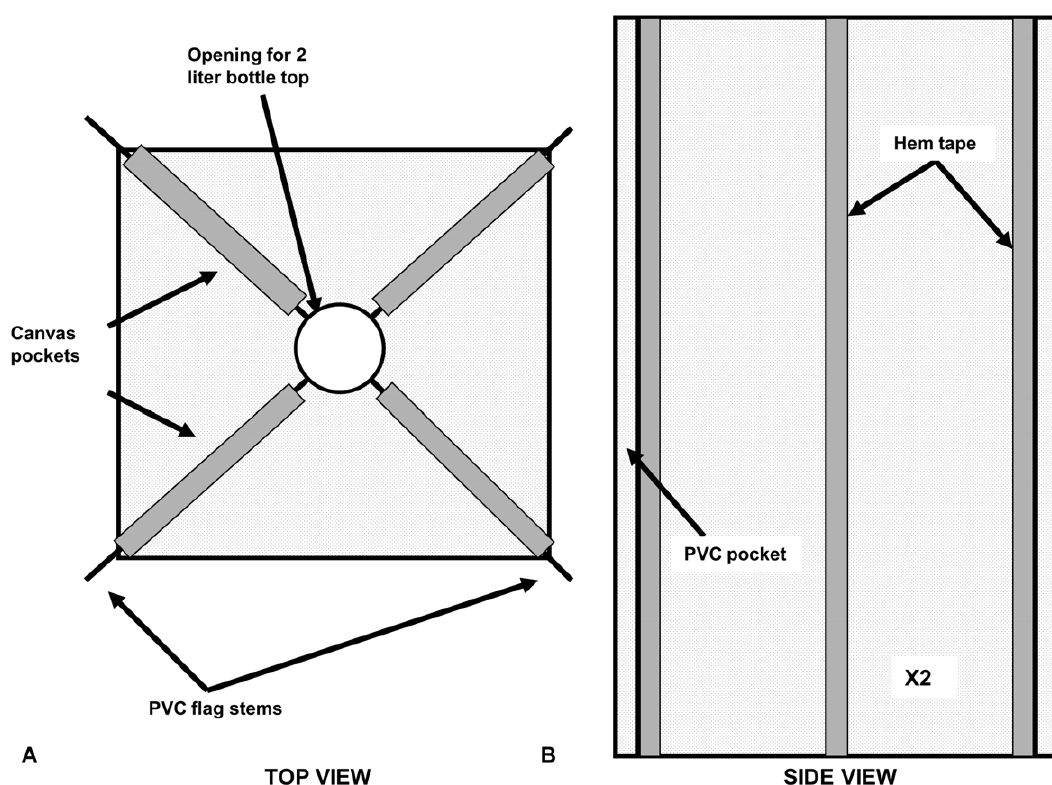
Figure 2. Mesh components of the Composite Insect Trap. Mesh fabric (bridal tulle) is represented by the dotted areas. A ) The mesh cut out for a cone trap. Four canvas pockets (solid) are sewn onto the diagonals and contain the PVC flag stems. B ) The mesh cut out for a flight intercept trap. Two of these fabric sections are sewn together along the center line, which is reinforced with hem tape. The pockets for the PVC pipes are along the sides and are also reinforced with hem tape.